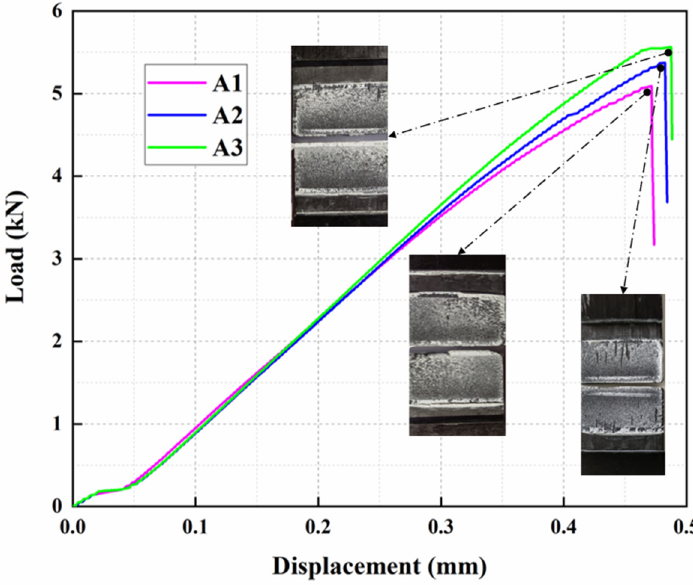
Figure 6. The load-displacement curves of single-lap specimens.